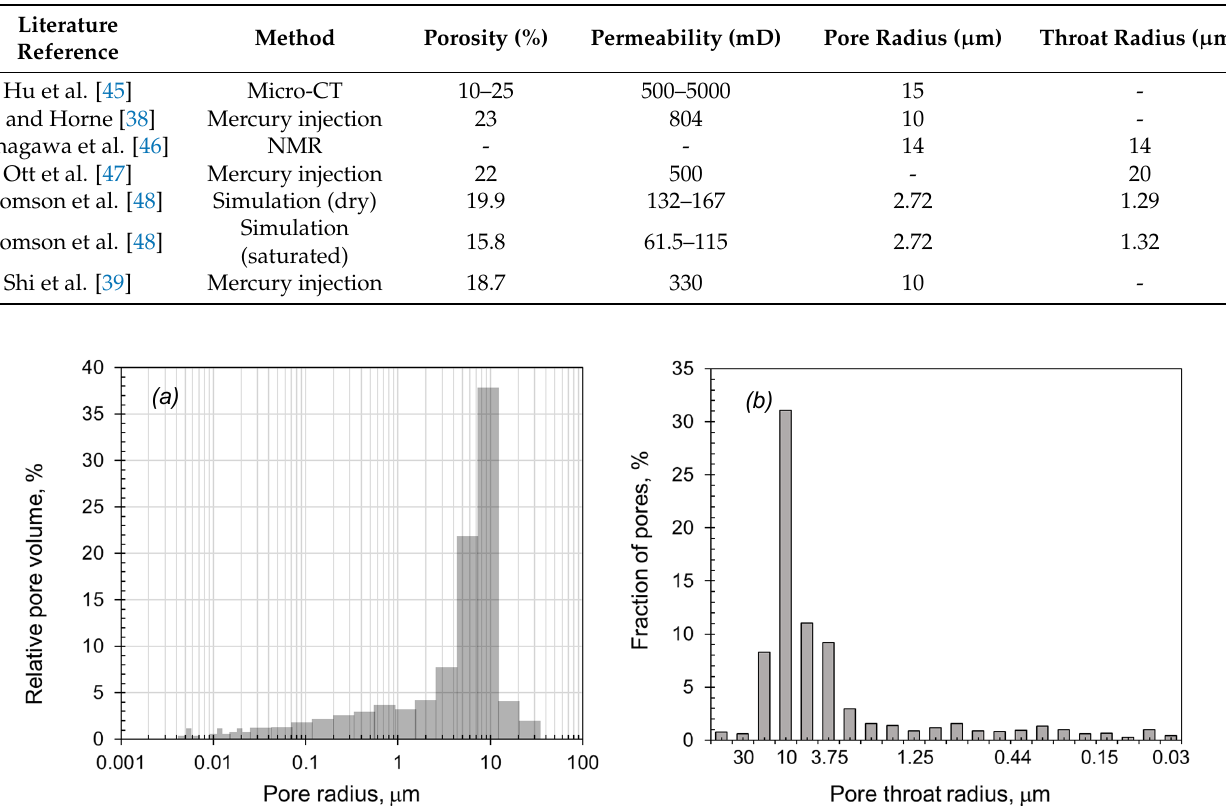
Figure 2. Pore size distribution of Berea sandstone reported in terms of ( a ) pore radius, extracted from Shi et al. [39], and ( b ) pore throat radius, extracted from Li and Horne [38]. Table 1. Pore and throat radii of Berea sandstone samples with respective porosity and absolute permeability. NMR is the Nuclear Magnetic Resonance.